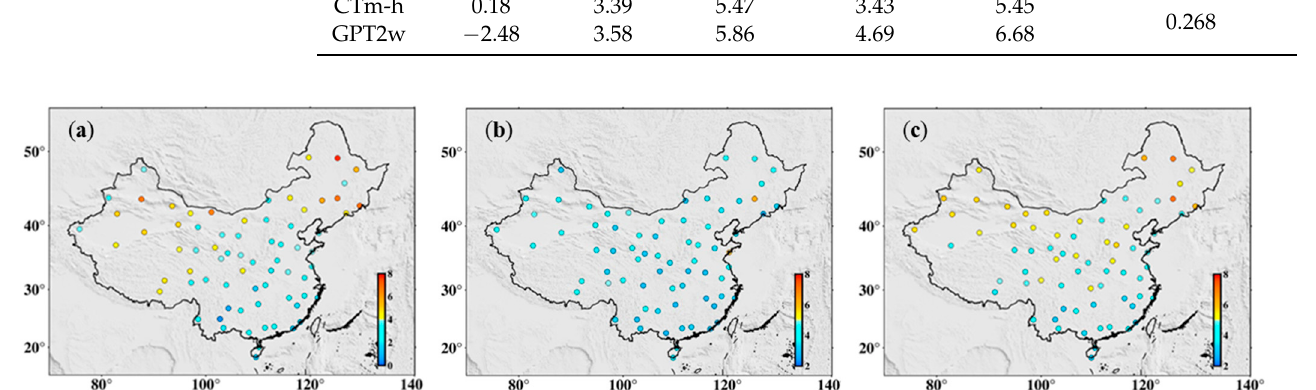
Figure 10. The average bias ( a ), SD ( b ), and RMS ( c ) of the CTm-h model verified by the radiosonde stations. Table 3. Precision statistics of CTm-h model of radiosonde station (K).